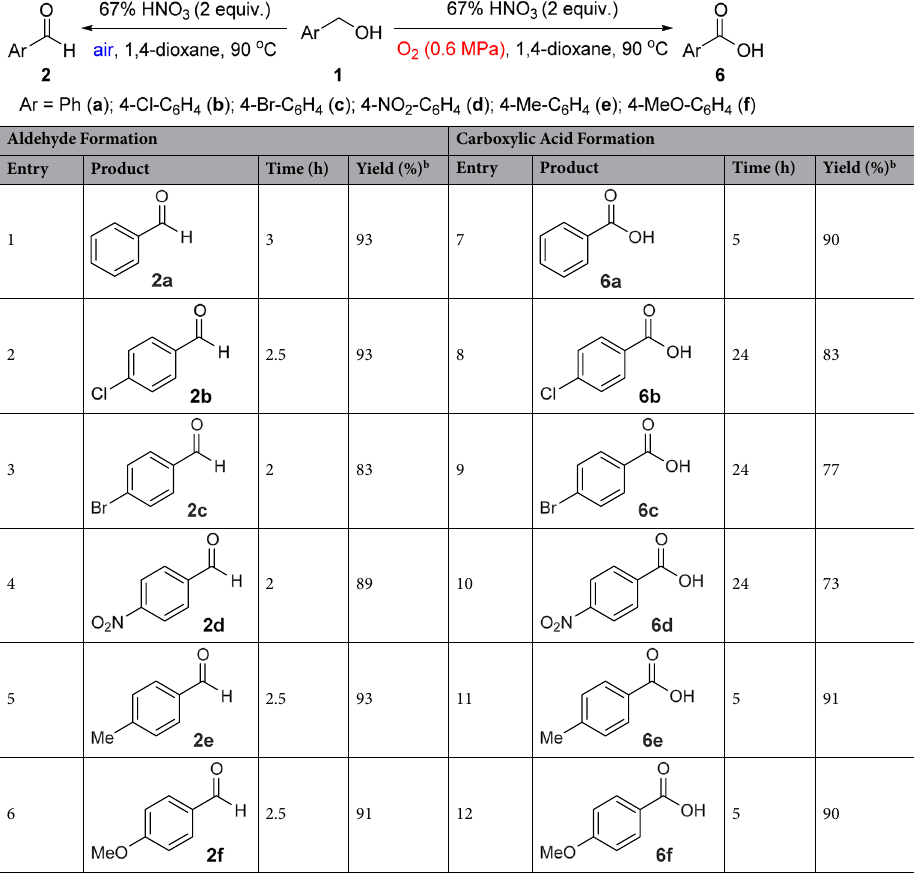
Table 4. Scope of chemoselective oxidation reactions a . a Reaction conditions for aldehyde formation: 1 (1 mmol), graphene oxide (5 wt%), 67% nitric acid (2 mmol), 1,4-dioxane (2 mL), air (1 atm), 90 °C; Reaction conditions for carboxylic acid formation: 1 (1 mmol), graphene oxide (5 wt%), 67% nitric acid (2 mmol),